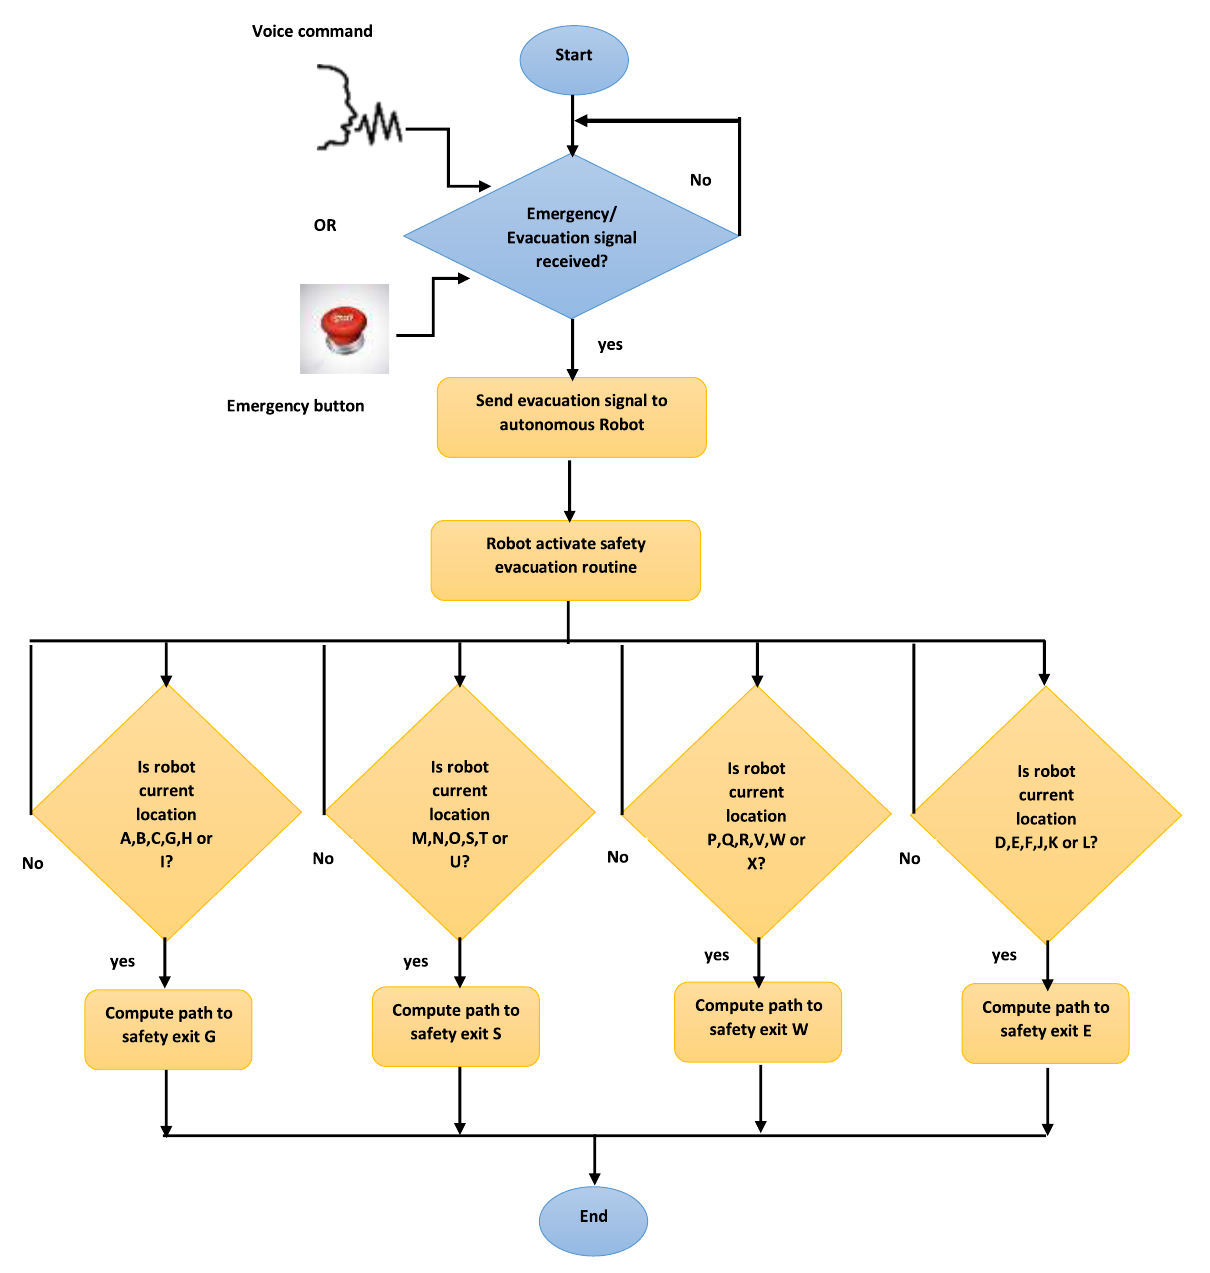
Figure 3. Safety response mechanism flow diagram